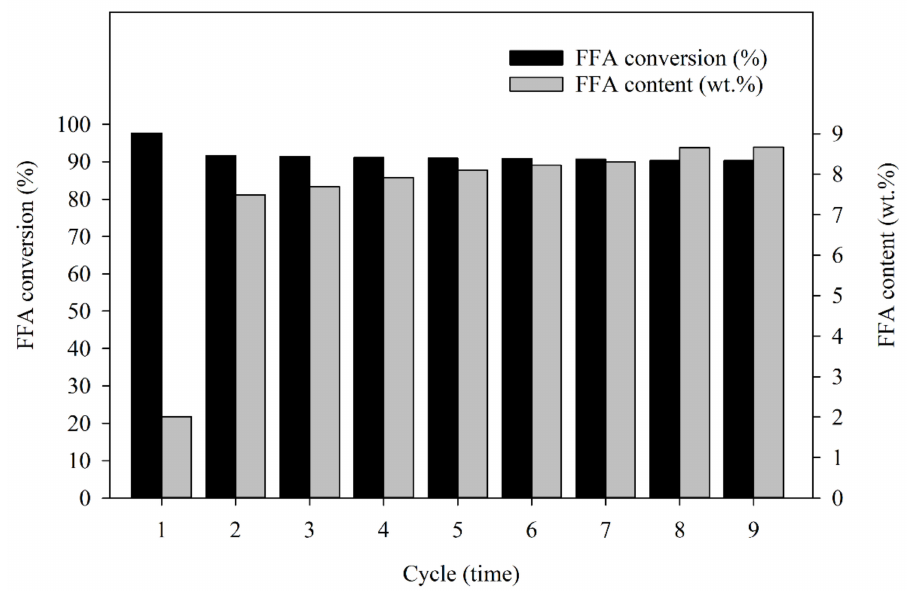
Figure 5. The FFA conversion (%) and FFA content (wt.%) in esterified oil from the first cycle through to the ninth